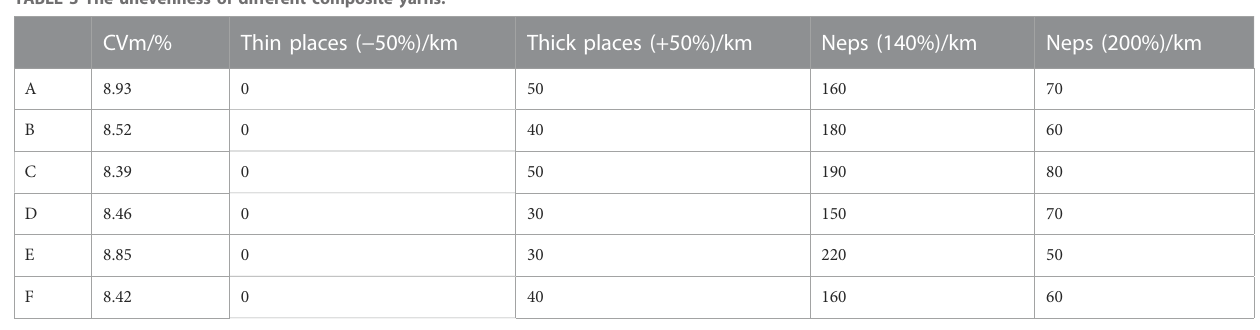
TABLE 3 The unevenness of different composite yarns.